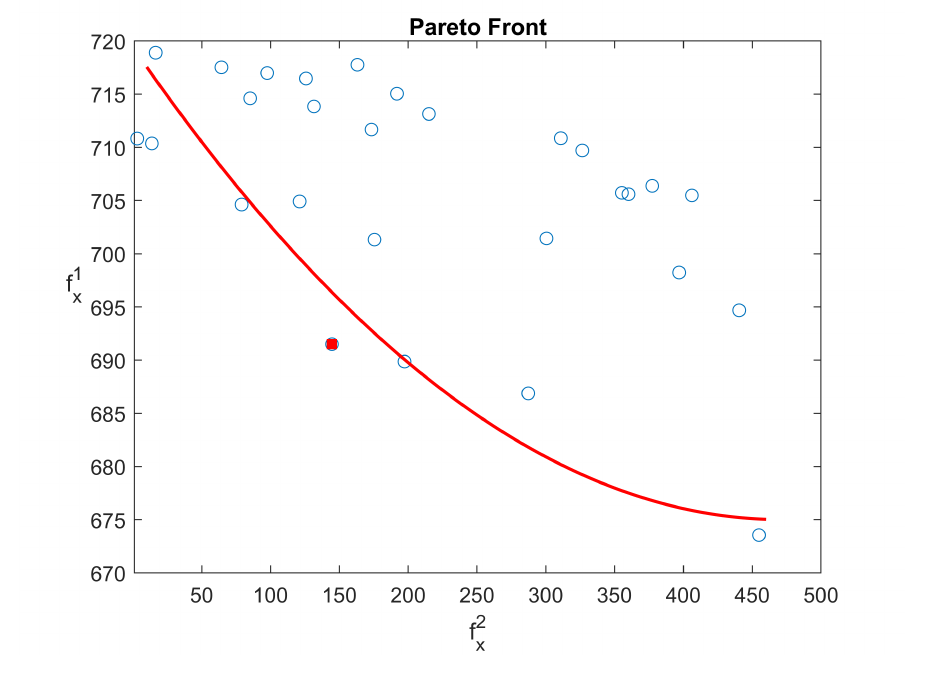
Figure 12. The Pareto Front.